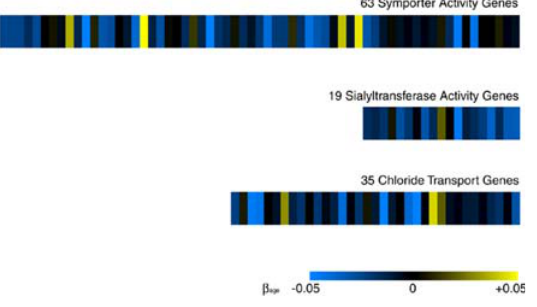
Figure 2. Three Gene Sets Are Regulated with Age in Muscle Rows represent the symporter activity, sialyltransferase activity, and chloride transport gene sets. Columns correspond to individual genes within a given gene set. Scale represents the slope of the change in log 2 expression level with age ( b 1j ). A navigable version of this figure showing identities of specific genes can be found at http://cmgm.stanford.edu/ ; kimlab/aging_muscle.